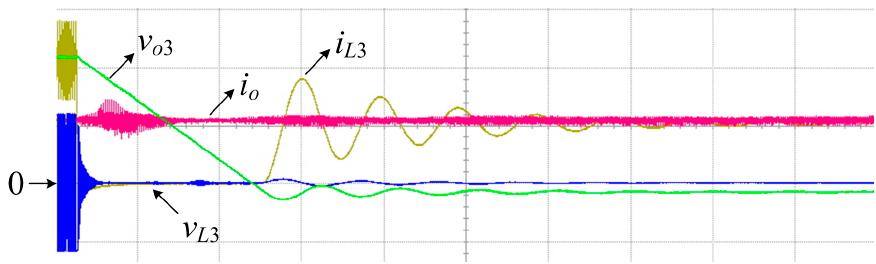
Figure 13. Isolating transients on v L 3 , v o3 , i L 3 , and i o .